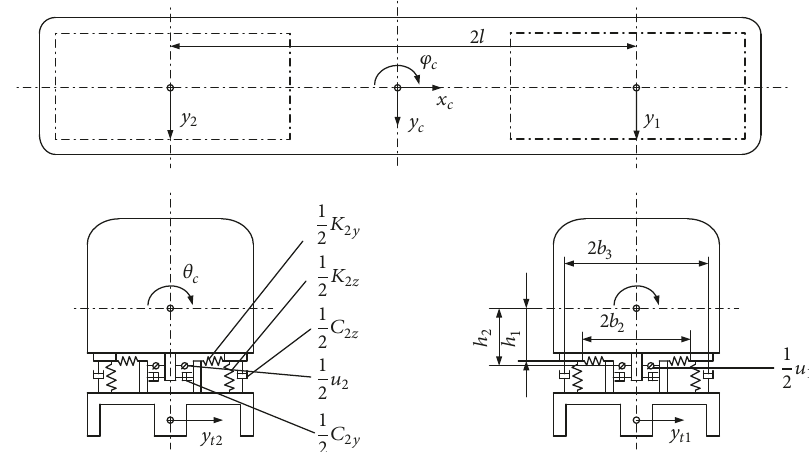
Figure 1: The control model for lateral semiactive suspension of rail